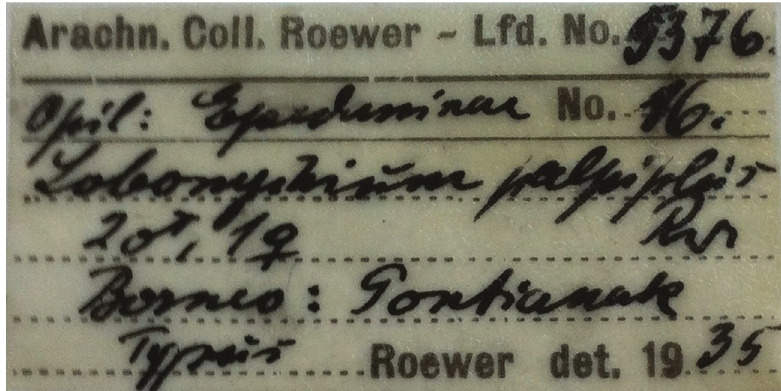
Figure 35. Original label with Roewer’s handwriting of the type series of Lobonychium palpiplus Roewer, 1938.